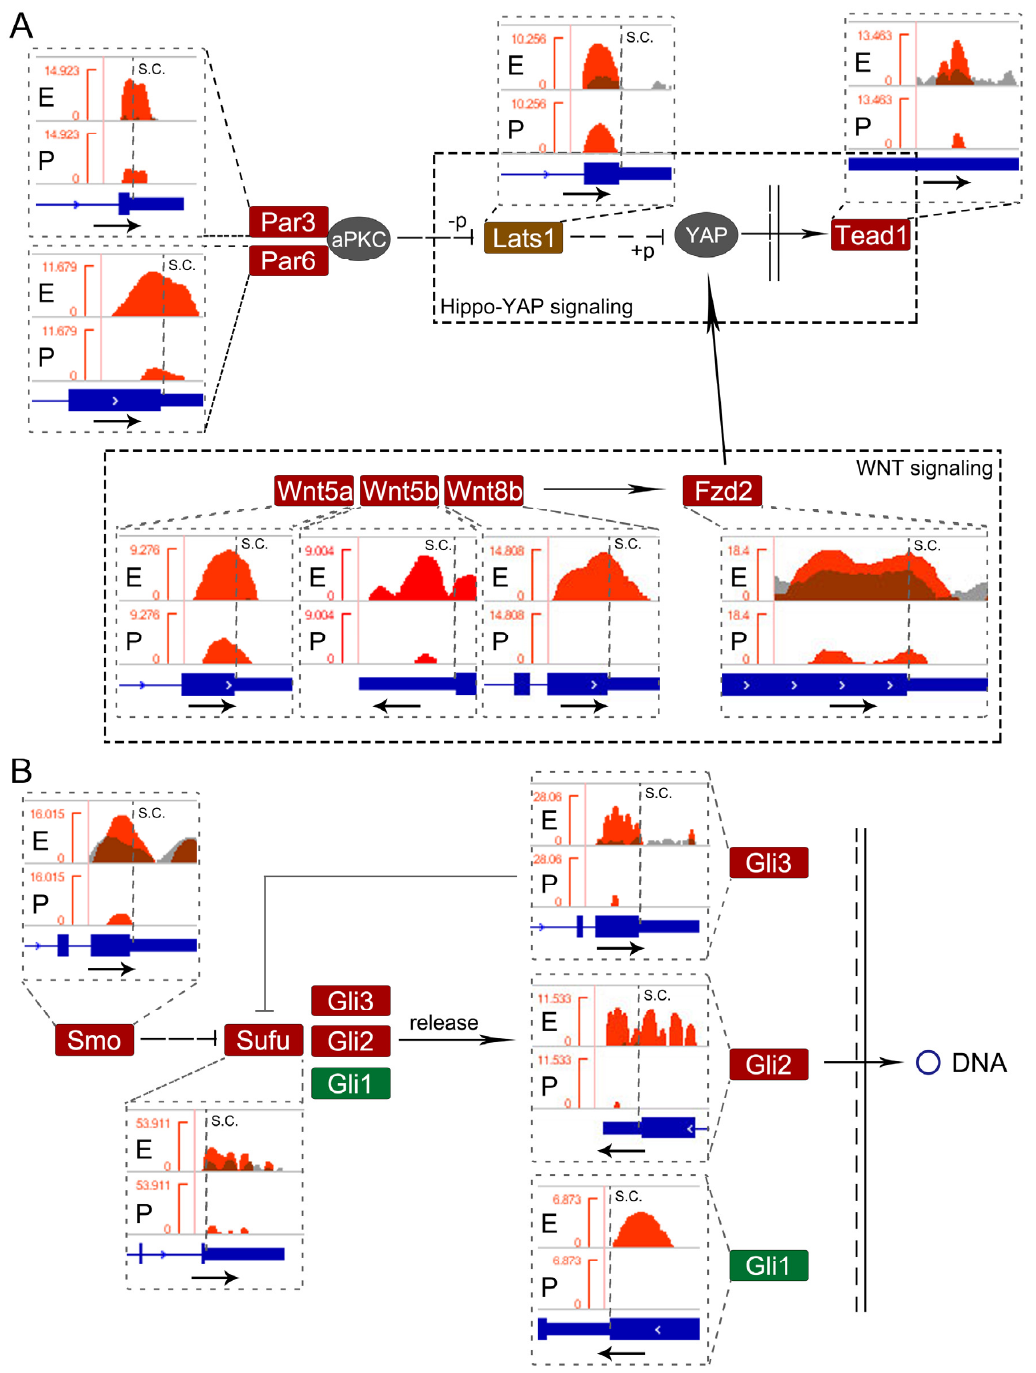
Figure 5. Status of m 6 A-methylation in genes in the hippo-YAP pathway and hedgehog pathway. ( A ) Integrative Genomics Viewer (IGV) analysis of four E-SMRs (Par3, Par6, Lats1 and Tead1) in the hippo-YAP pathway. Four Wnt-related E-SMRs (Wnt5a / b, Wnt8b and Fzd2) participated in the hippo-YAP pathway. ( B ) IGV analysis of five E-SMRs (Smo, Sufu, Gli1 / 2 / 3) in the hedgehog pathway.